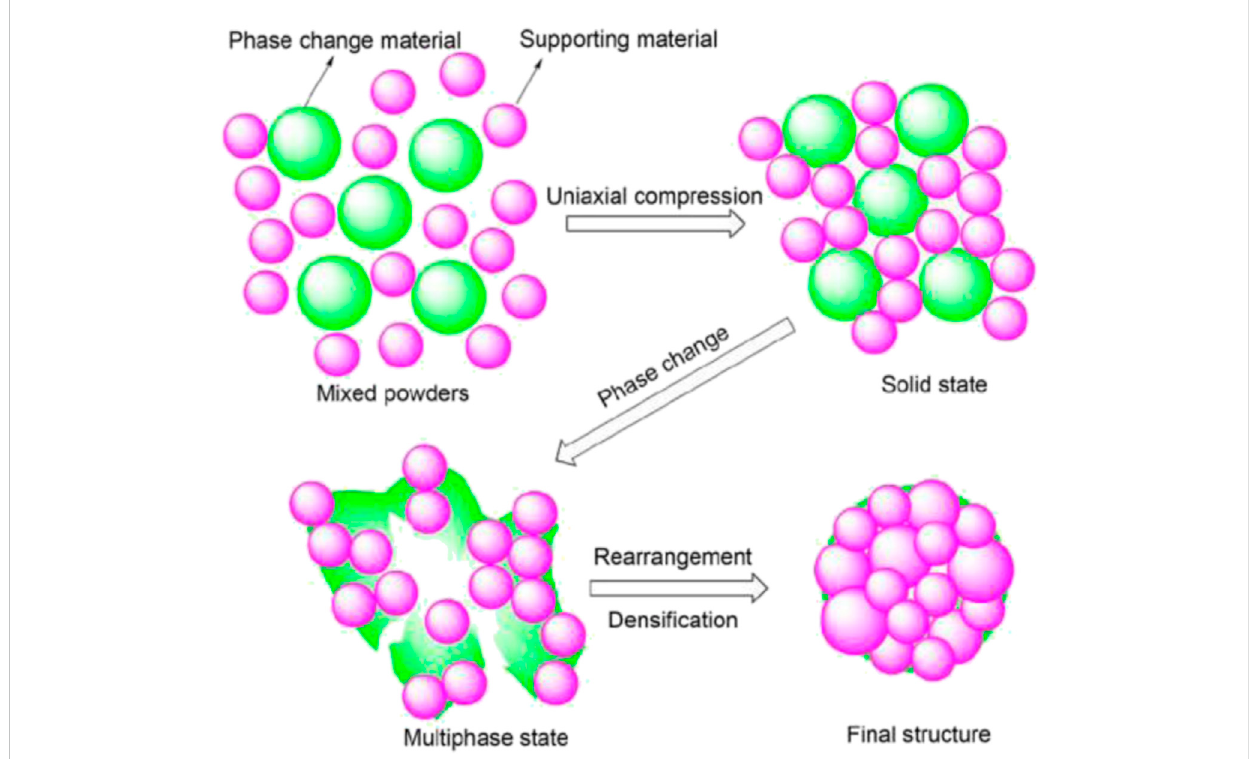
FIGURE 2 Schematicof themechanism ofmicrostructure development in PCM and ceramic Skeltonmaterials (Ge etal., 2014). Licencenot required (Creative Commons CC-BY